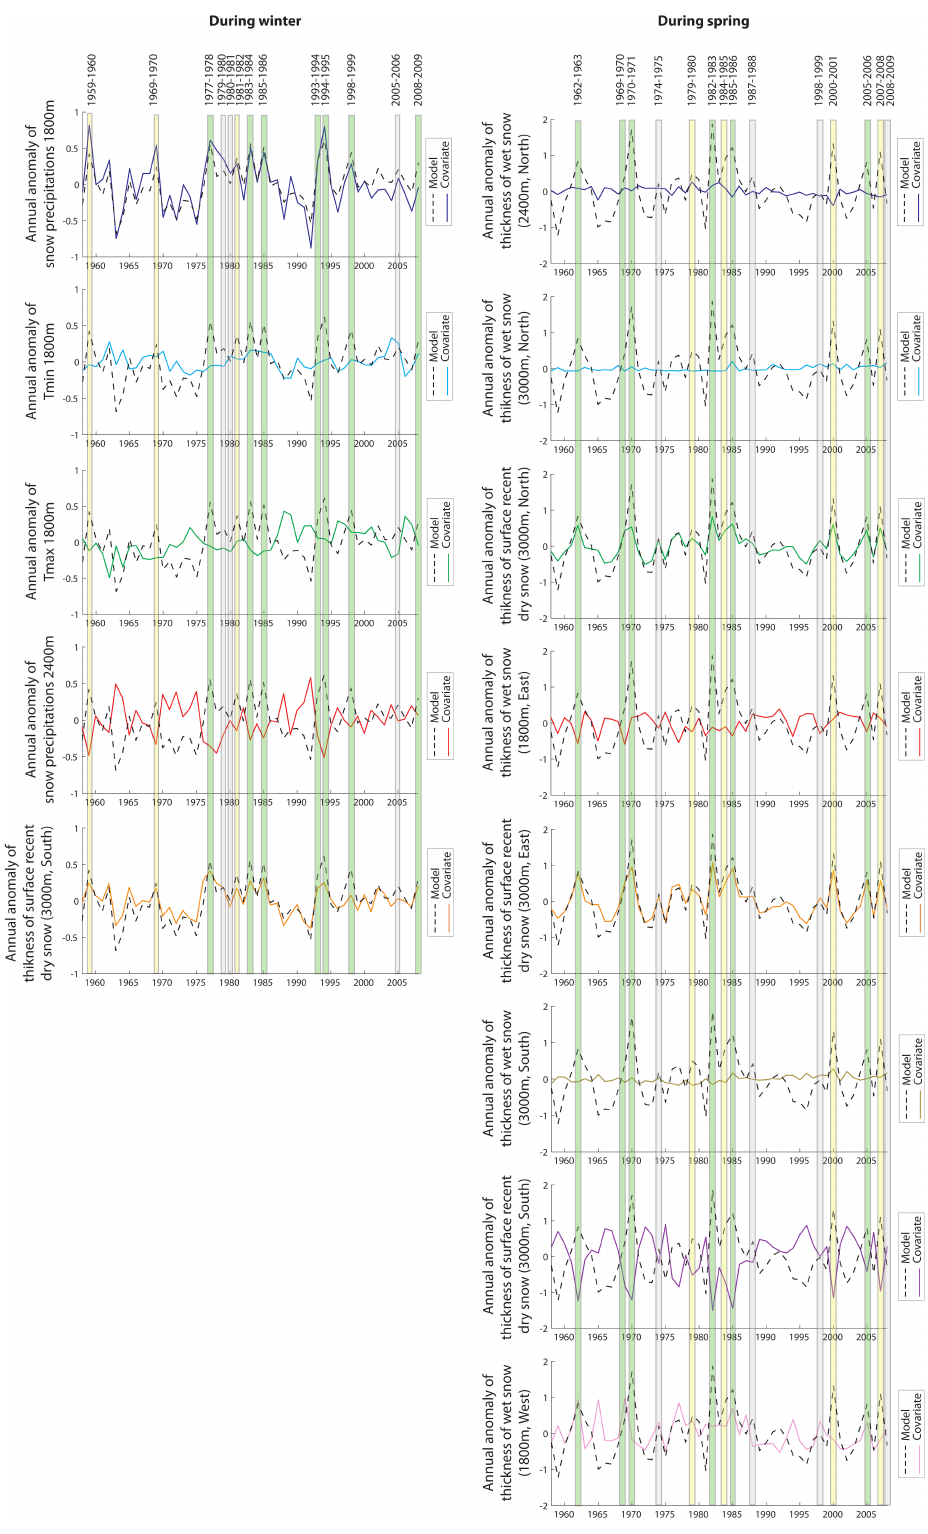
Fig. 8. Temporal evolution of the covariates retained in the regression model of the composite index, during winter (15 December to 14 March) and spring (15 March to 15 June) in the entire French Alps. Green bands correspond to years for which the CI and its regression model exceed the 80th percentile threshold (see Table 2). Yellow and grey bands correspond to years for which only the model or the CI exceeds the threshold,